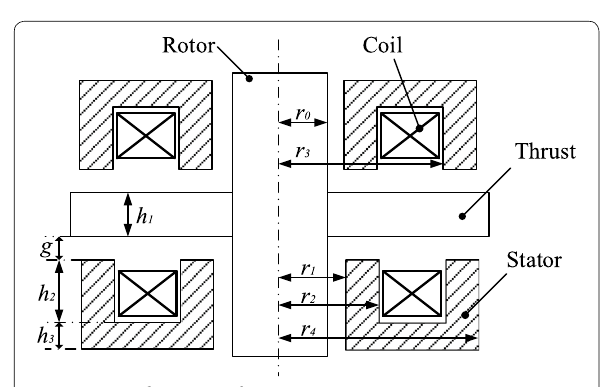
Figure 2 Configuration of AMBs